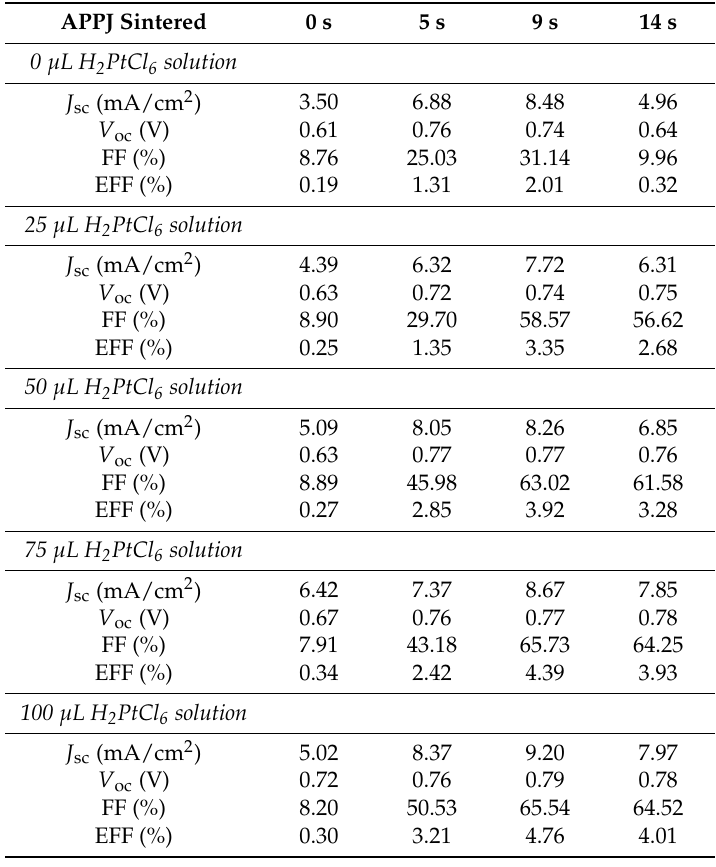
Table 1. Tabulated DSSC parameters extracted from IV curves. 0 µ L, 25 µ L, 50 µ L, 75 µ L, 100 µ L H 2 PtCl 6 solution added in the